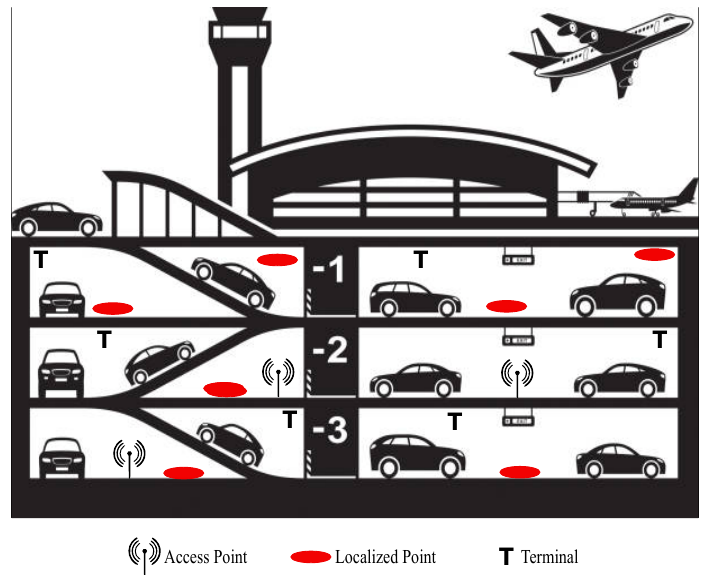
Figure 1. Example of environment setting: a multi-level car park at the